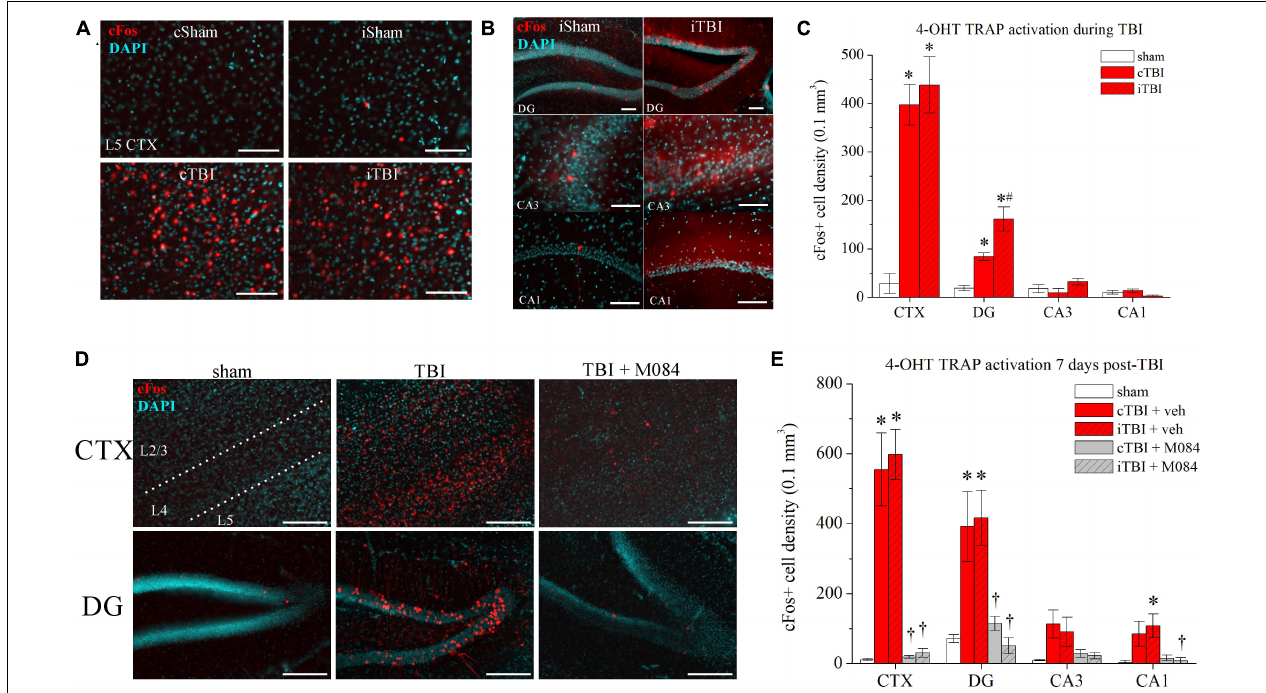
FIGURE 3 | Surges in neuronal activity following CCI-TBI are TRPC4/TRPC5-mediated. (A) Representative images of parietal cortex from sham and TBI TRAP mice that were administered 4-OHT at t = 12 h before procedure. Prefix “ c ” denotes contralateral, prefix “ i ” denotes ipsilateral. Red = cFos-tdTomato; blue = DAPI. (B) Representative images of hippocampal subregions from sham and TBI TRAP mice that were administered 4-OHT at t = 12 h before procedure. (C) Summarized quantification of cFos+ neuron density (neurons/0.1 mm 3 ) in sham and TBI TRAP mice activated at the time of TBI, as in Panels (A,B) . (D) Representative images taken from sham mice, TBI mice, and TBI mice also administered M084 (10 mg/kg) (TBI + M084) that were administered 4-OHT t = 7 days after procedure. (E) Summarized quantification of cFos+ neurons in sham, TBI, and TBI + M084 mice 7 days after procedure, as in Panel (D) . All data bars represent the mean ± SEM. * p < 0.05 vs. sham. # p < 0.05 vs. TBI cDG. † p < 0.05 vs. TBI of same region. Scale bars: 100 µ m.